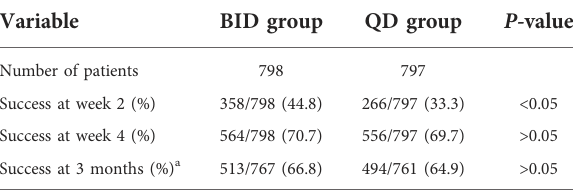
TABLE 1 Comparison in success outcomes of patients between the BID group and QD